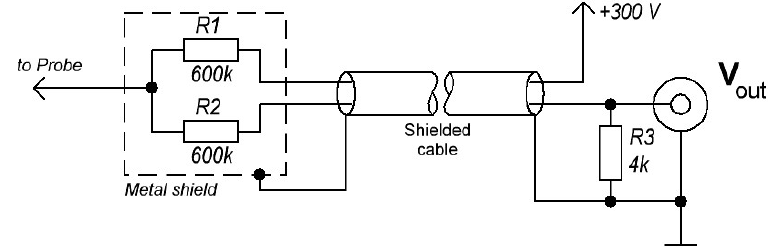
Figure 5. Electrical circuit of the ion sensor with external divider.